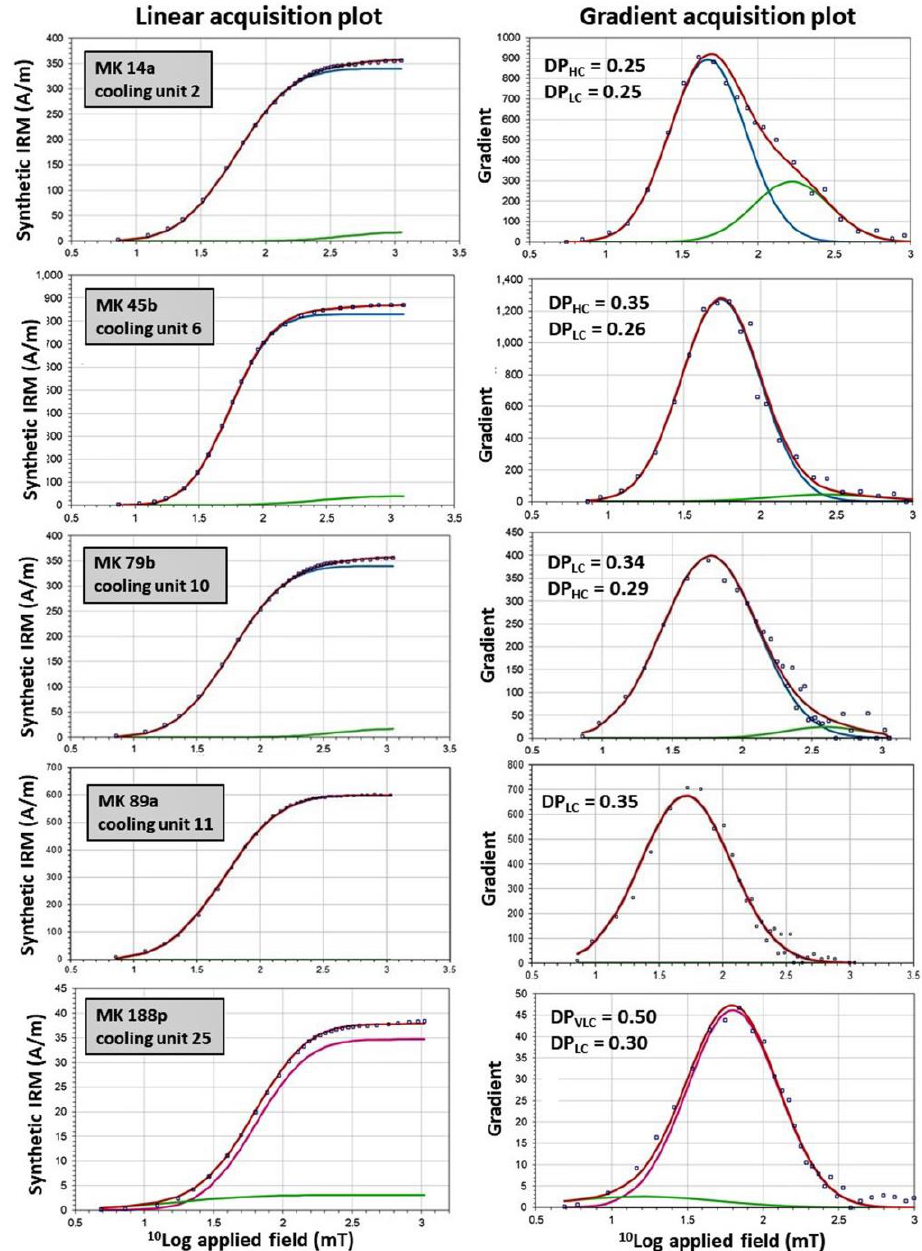
Figure 5. Typical IRM acquisition and interpretation of magnetic coercivities of selected samples. Left are the linear acquisition plots of IRM (LAP) and at right are the corresponding gradient acquisition plots (GAP).